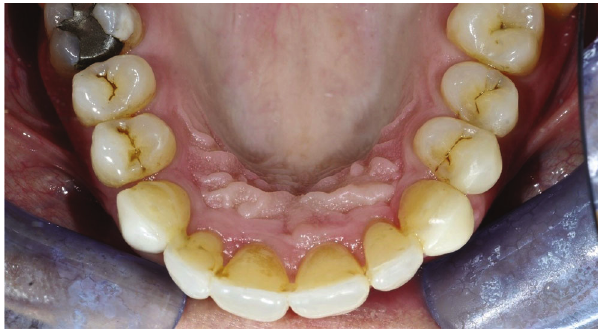
Figure 11: Clinical case: occlusal view, lower jaw, prosthetic